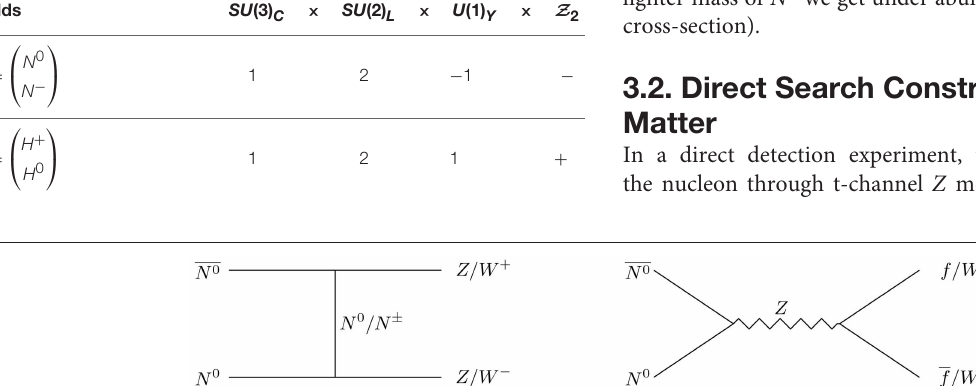
TABLE 1 | Quantum numbers of additional dark sector fermion and SM Higgs Z 2 . SU (3) C SU (2) L U (1) Y under G ≡ × × × Fields